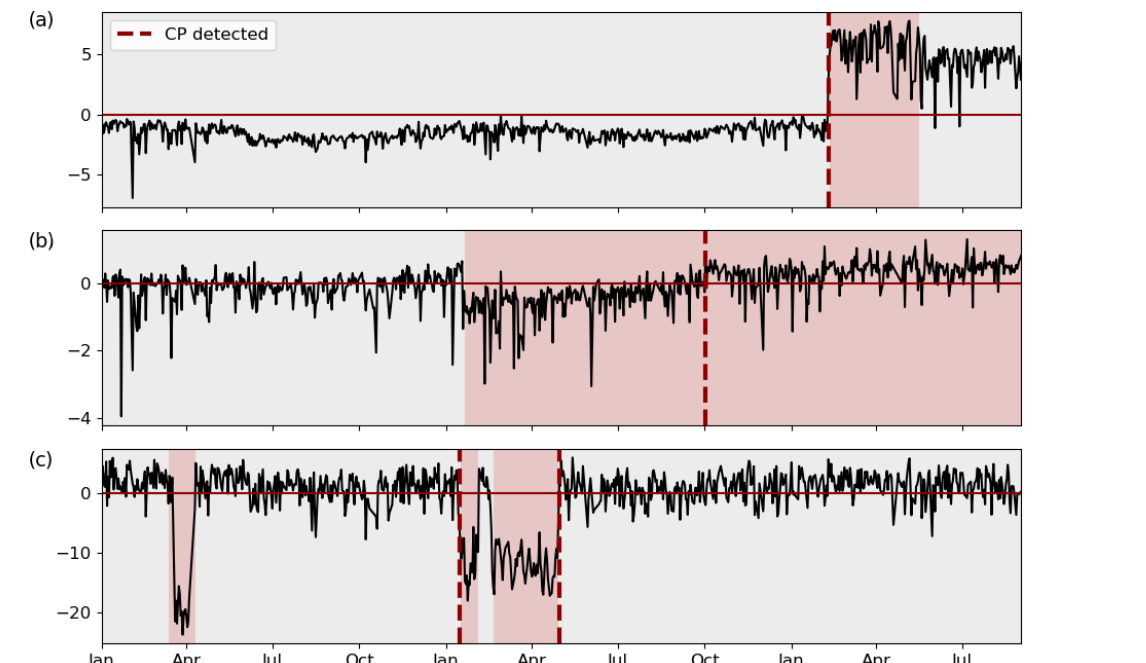
Figure 11. Examples of partially correct classified oil temperature (a) , gearbox bearing temperature (b) , and pitch motor winding temperature (c) . Each change in background colour indicates a true CP; each dashed line indicates a detected